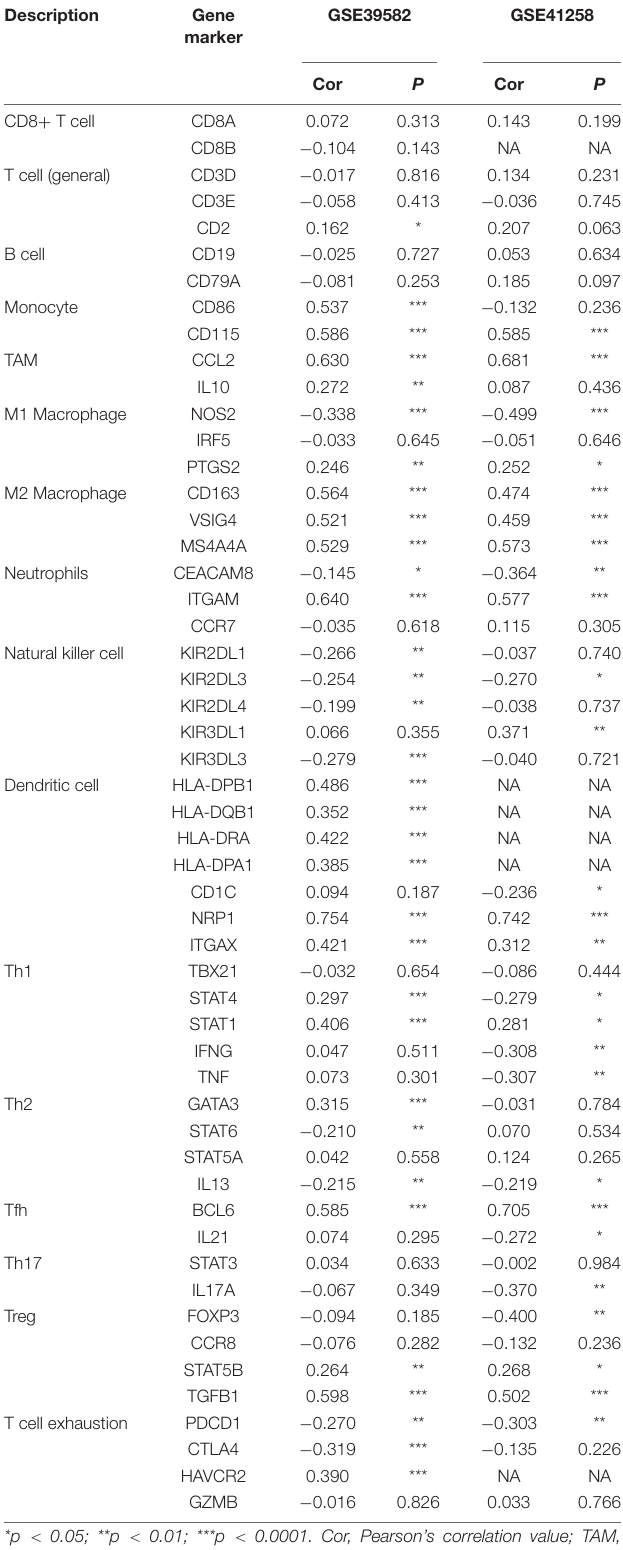
TABLE 3 | Correlations between CALD1 and immune cells markers.